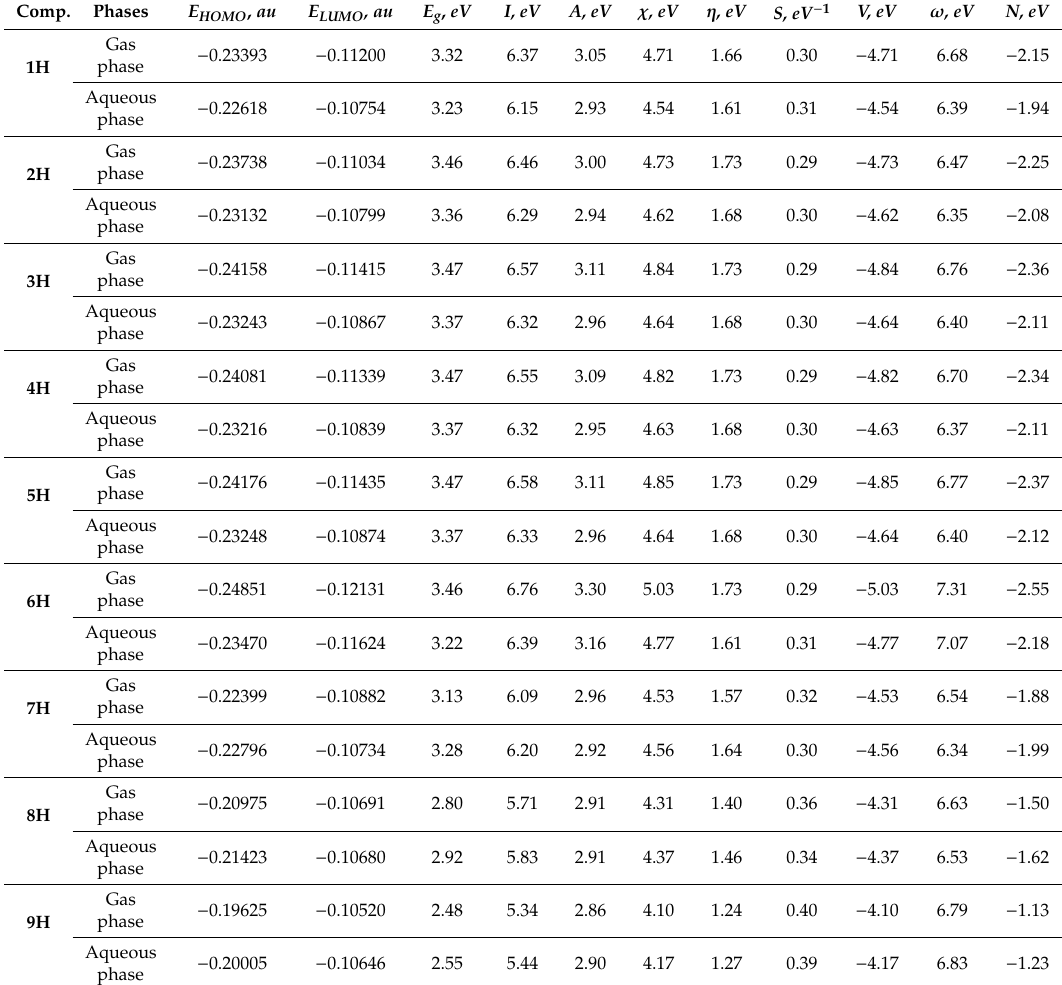
Table 4. Global reactivity descriptors of the TUDHIPP derivatives (1H–9H), at B3lyp / 6-311 ++ G ( d , p ) level of calculation in gas and aqueous